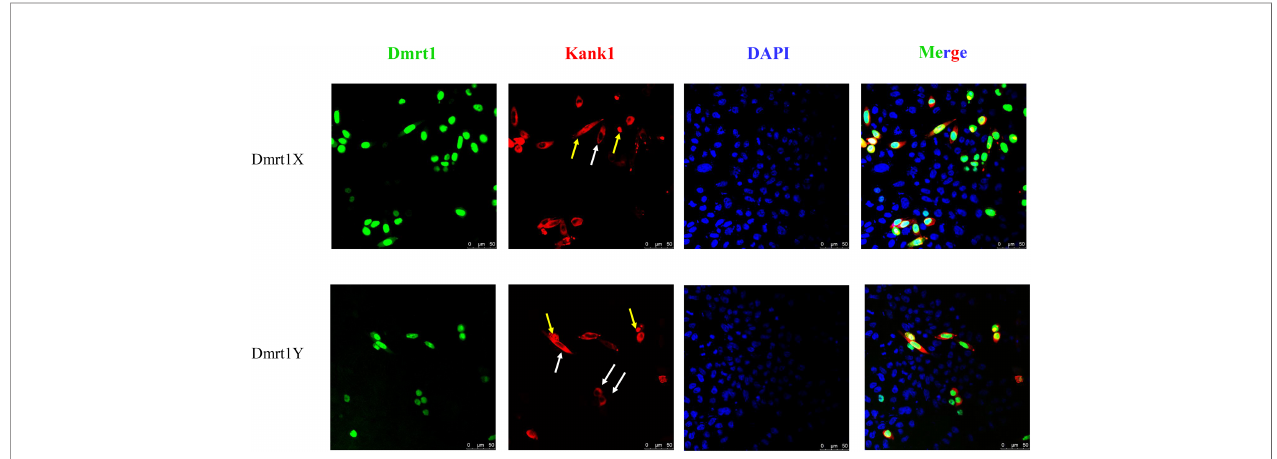
FIGURE 8 | Co-transfection pCS2-dmrt1-EGFP and pCS2- kank1 -mCherry into the CHO cells. Kank1 expressed in cytoplasm (white arrows) and in cell nucleus (yellow arrows). Scale bars: 50 m